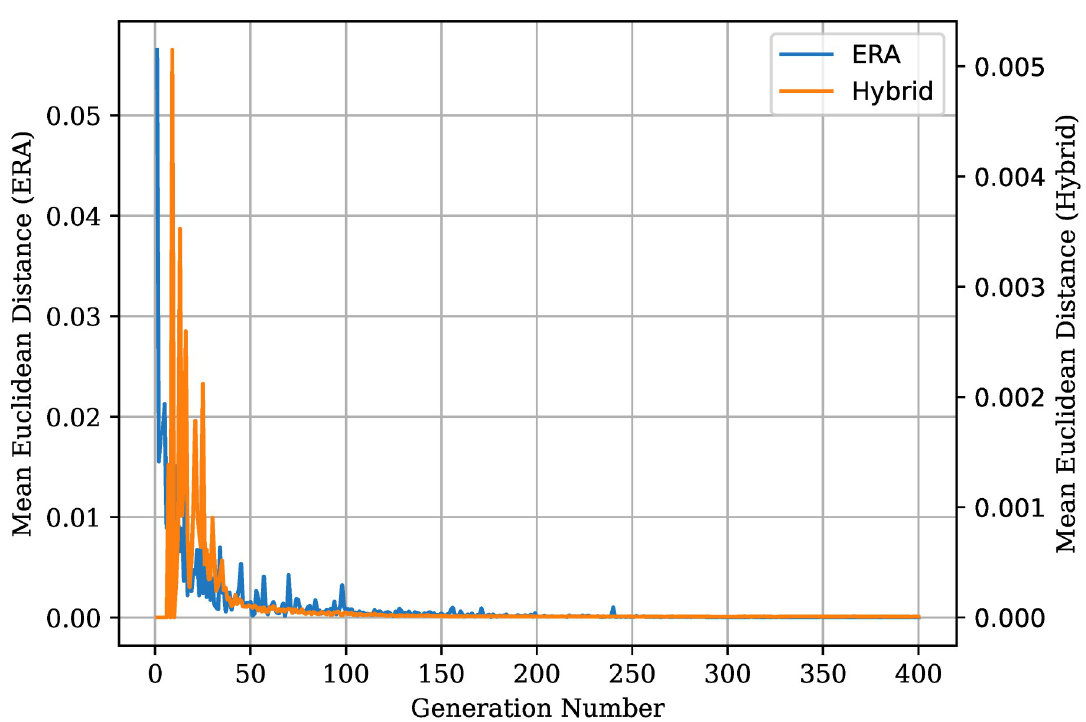
Fig 8. Mean Euclidean distance between successive Pareto Frontsfor both the Hybrid and non-Hybrid versions of the ERA.